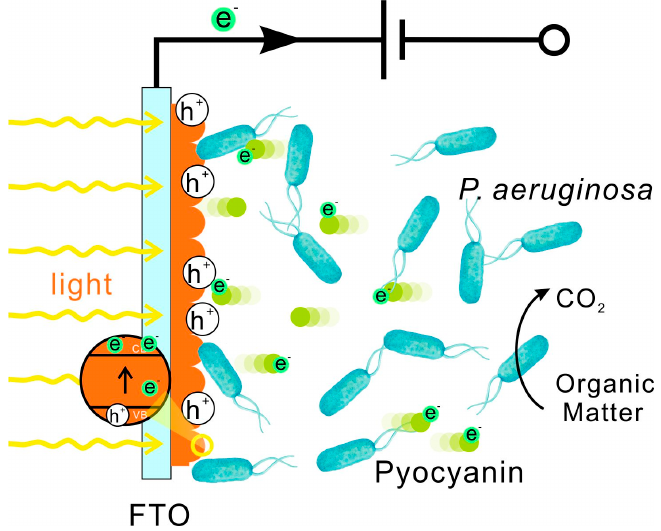
Figure 8. Schematic diagram of the electron transferring process between hematite and PAO1 under visible light irradiation.